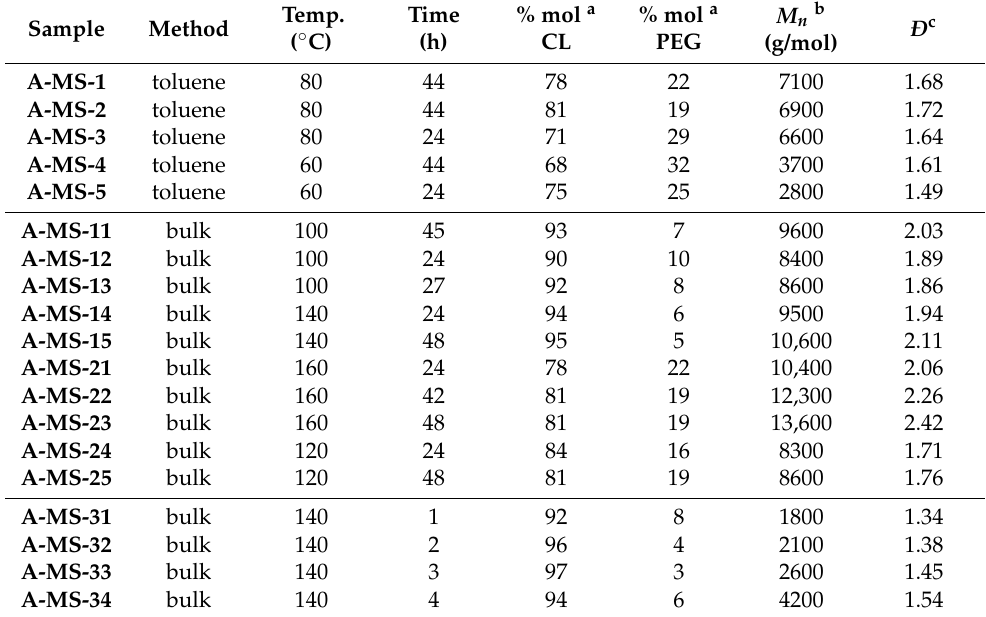
Table 1. Copolymerization of CL and PEG in the presence of Zr(Oct) 4.